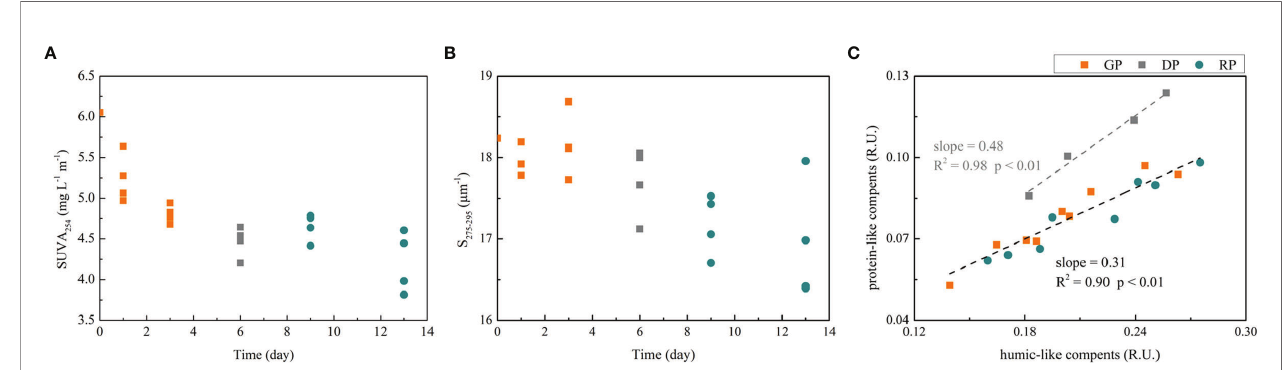
FIGURE 6 | (A) The variation of SUVA 254 in different algae phases of the four groups; (B) The variation of S 275-295 in different algae phases of the four groups; (C) The relationship between protein-like components and humic-like components of the